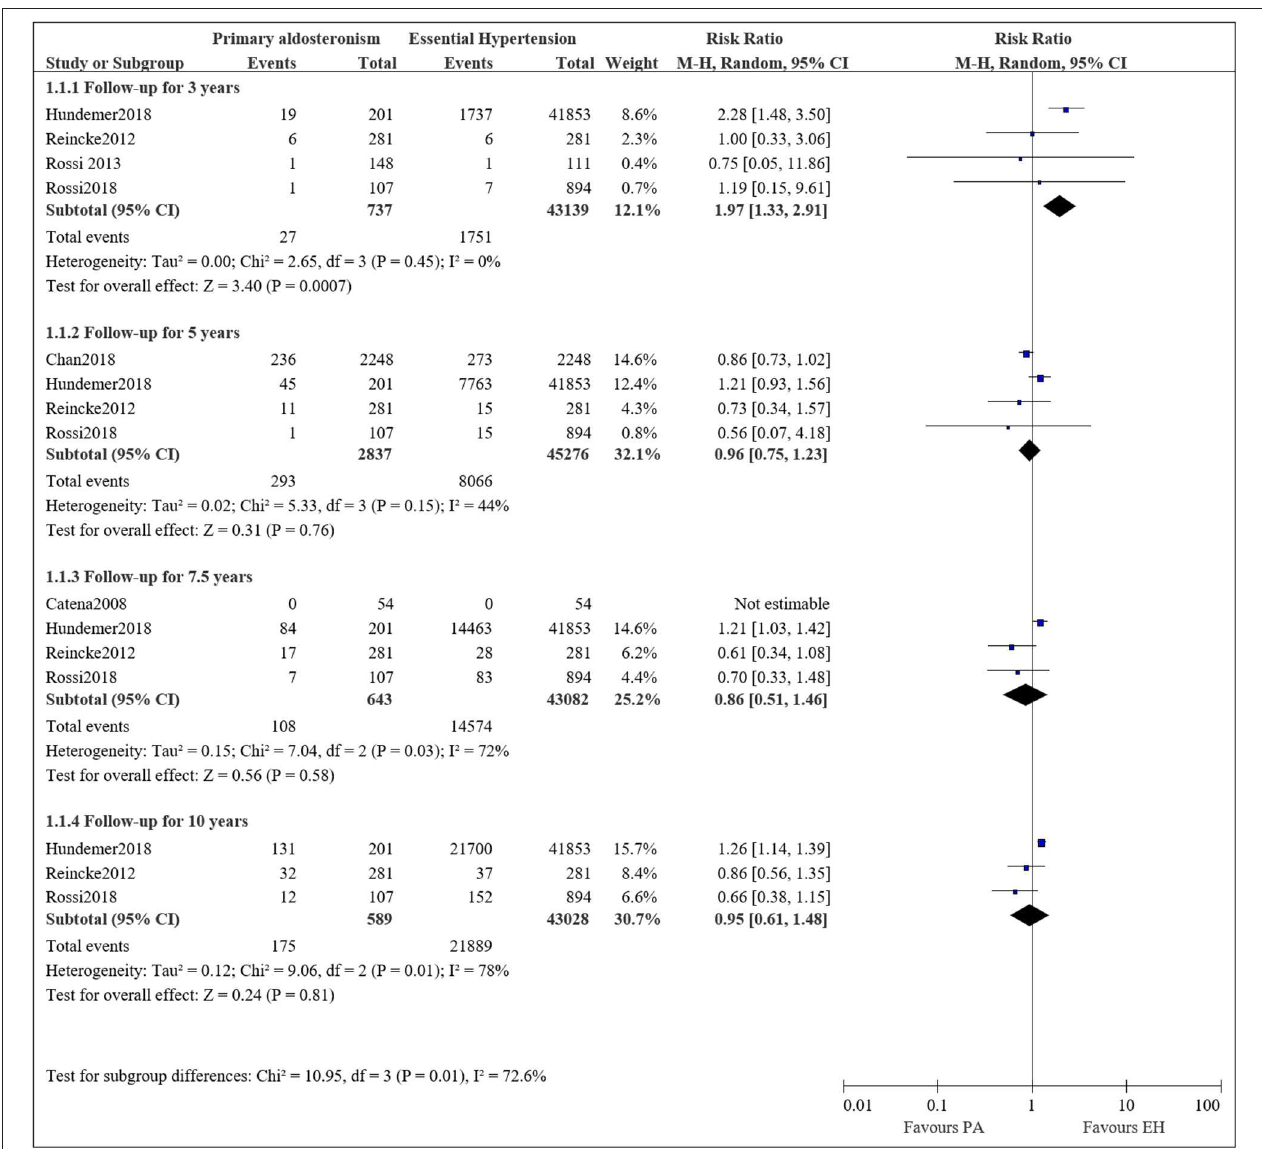
FIGURE 2 | Comparison of patient with PA and EH of the risk of mortality at different follow-up times.